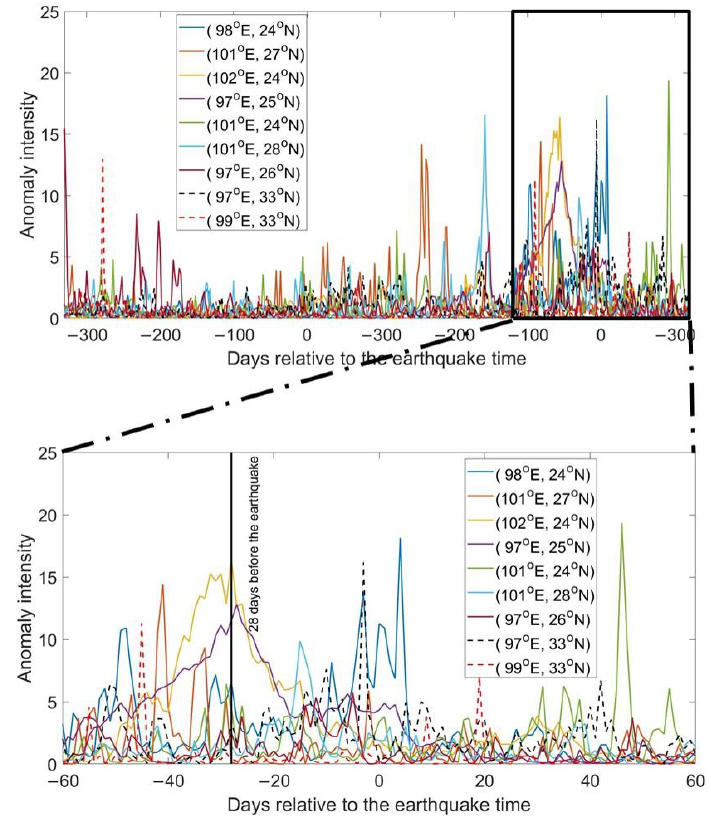
Figure 15. The time curves of abnormal values. The most obvious anomaly is at 102°E, 24°N. It lasted for 25 days and had the highest peak among all pre-seismic anomalies. Significant anomalies were observed near both two epicenters three days before the earthquakes. (The dark blue solid line and the black dotted line). The relative power spectrum on that day is shown in Figure 16. The anomaly value around the Qinghai epicenters is slightly higher than that around the Yunnan epicenters. It is in accordance with the magnitude of the two earthquakes. The strongest pre-seismic anomaly around the Yunnan epicenter occurred 28 days before the earthquake. As Figure 17 shows, a large-area anomaly appeared in the southeast direction of the epicenter, and the closest distance to the epicenter was less than 300 km.